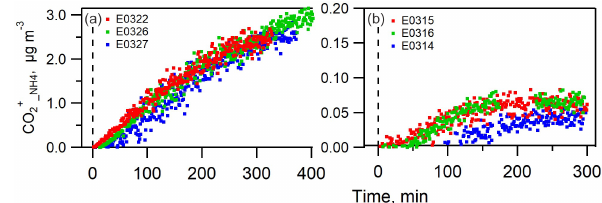
Figure 3. The estimated amount of organic carboxylic acid needed to fully neutralize SOA particles (CO + is chosen to represent organic acids. (a) Nucleation experiments. (b) Seeded experiments. The time zero marks the beginning of pho- tooxidation reactions when UV lights were switched on.